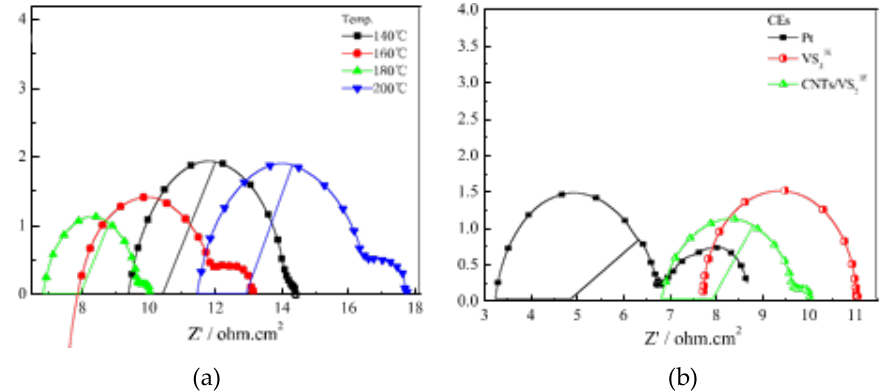
Figure 10. Nyquist plots of ( a ) VS 2 samples synthesized at different temperatures and ( b ) VS 2 /CNT, VS 2 , and Platinum CEs. Reproduced with permission from Reference [39], Elsevier 2017.